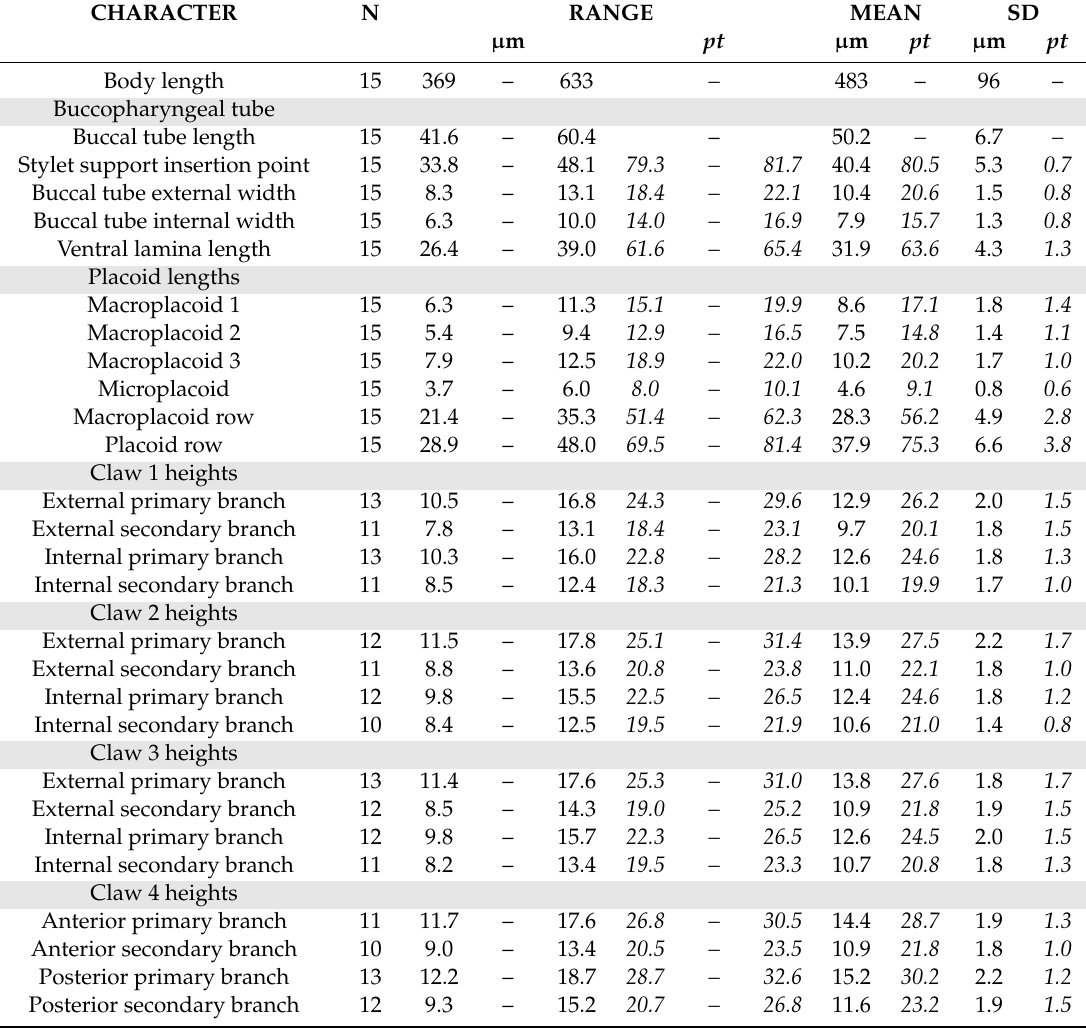
Table 5. Measurements (in µ m) and pt values of selected morphological structures of individuals of the Polish (cultured) population of Paramacrobiotus fairbanksi Schill, Förster, Dandekar and Wolf [25] mounted in Hoyer’s medium (N, number of specimens / structures measured; RANGE refers to the smallest and the largest structure among all measured specimens; SD, standard deviation; pt , ratio of the length of a given structure to the length of the buccal tube expressed as a